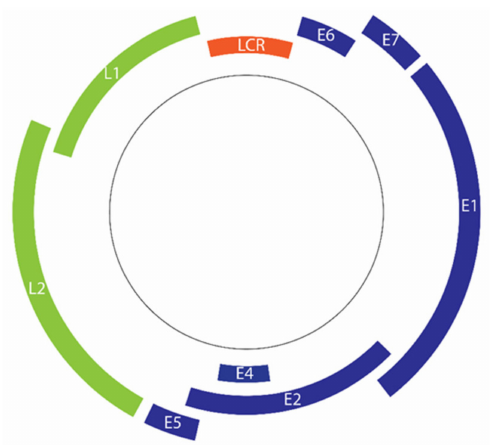
Figure 2. Organization of the HPV 16 genome. Deferent regions code for early genes (blue) and late genes (green). Transcription of early genes is regulated by the long control region (LCR) (Orange). Similar to promoter methylation in the host genes, DNA methylation in the viral LCR may downregulate the transcription of early viral genes [132]. This downregulation is often associated with the deregulation of transcription factor binding [132–134]. Binding of methyl CpG binding proteins to the methylated sites is also known to obstruct transcription factor binding [132]. However, LCR methylation does not necessarily cause transcriptional silencing. Instead, selective methylation can even cause overexpression of early viral proteins [135].